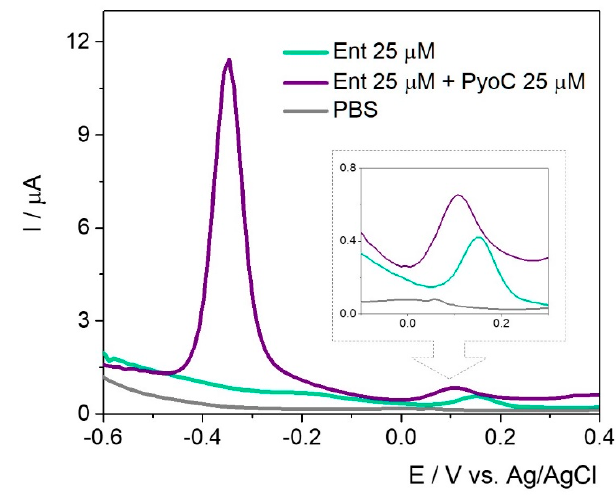
Figure 8. DPV for 20 mM PBS pH 7.4 (grey), 25 μ M Ent (green), and 25 μ M Ent + 25 μ M PyoC (purple) on agar:Au/Ag nanoalloy platform developed on in ‐ lab printed electrode on thin